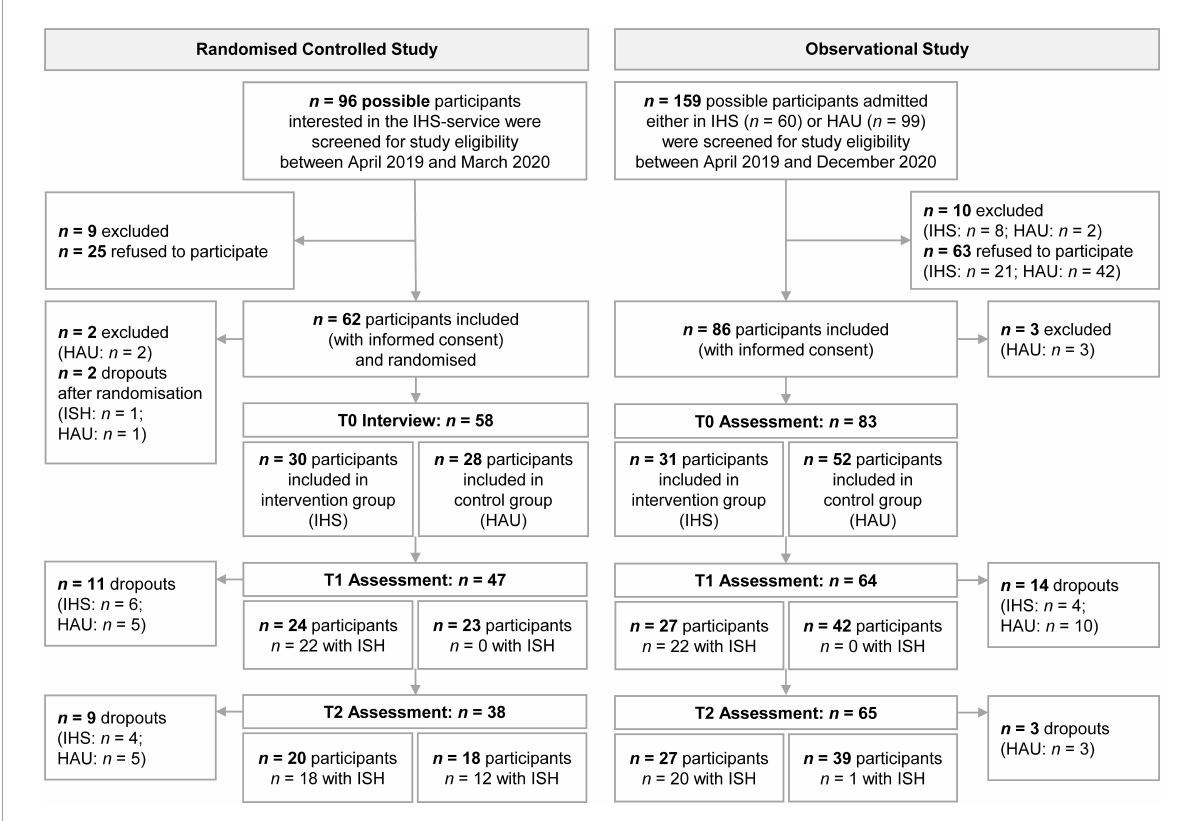
FIGURE1 Flow chart of participants’ recruitment and follow-up. ISH, Independent Supported Housing; HAU, housing as usual; n , sample